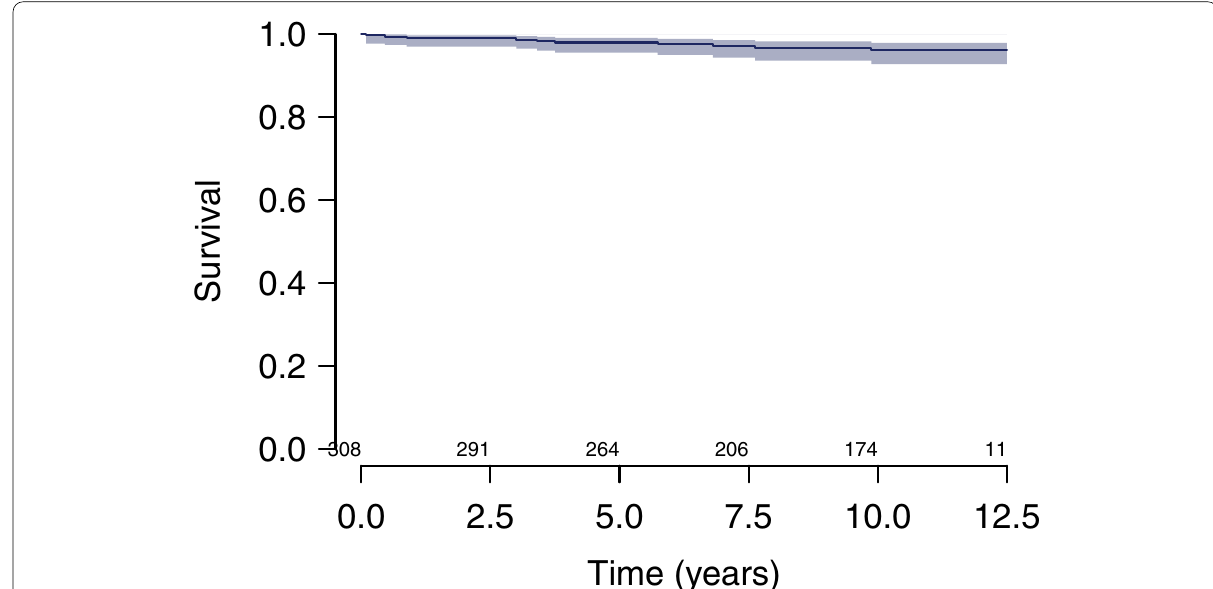
Fig. 4 Survival at 10 years estimated using the KM method was 96.1% (CI, 92.8–97.9%) considering stem revision for any reason as endpoint